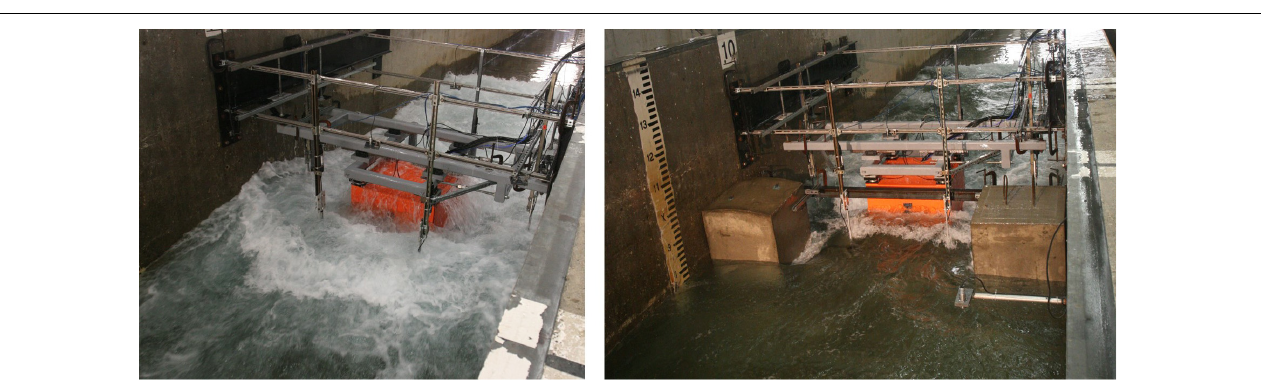
Frontiers in Built Environment |